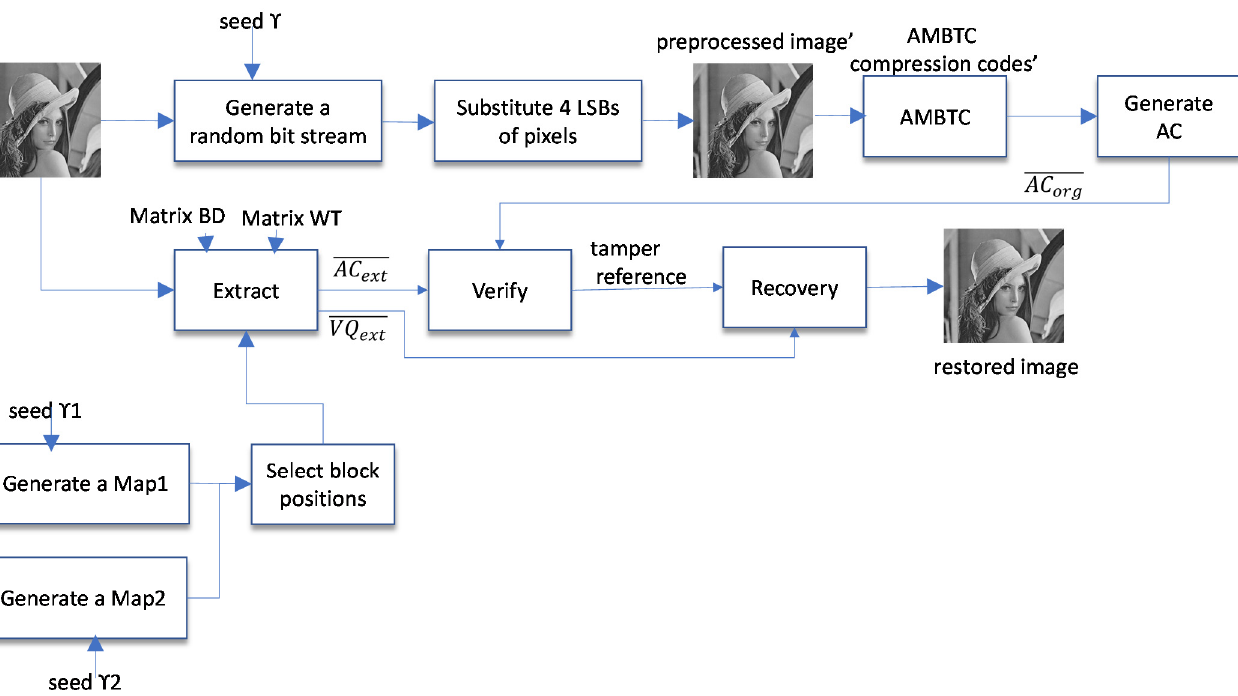
Figure 8. Authentication and recovery process.